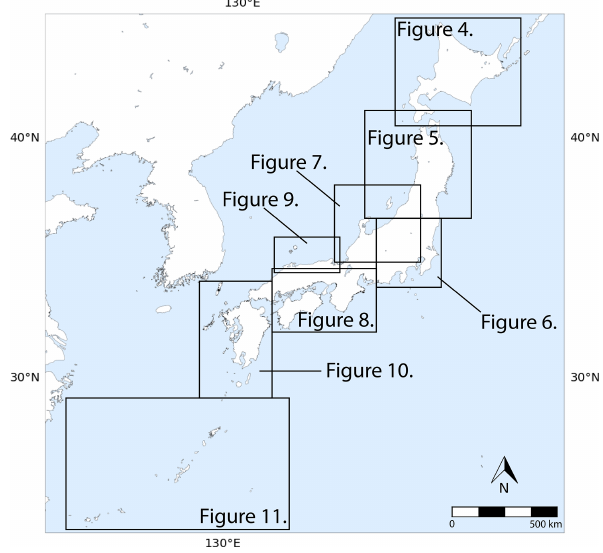
Figure 3. Map of Japan, indicating subsections in which MIS 5e sea-level proxies are